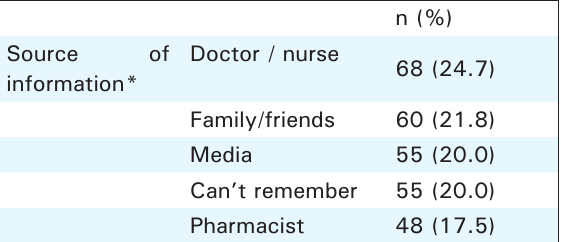
Table 2. Source of information regarding antibiotic use and its resistance.